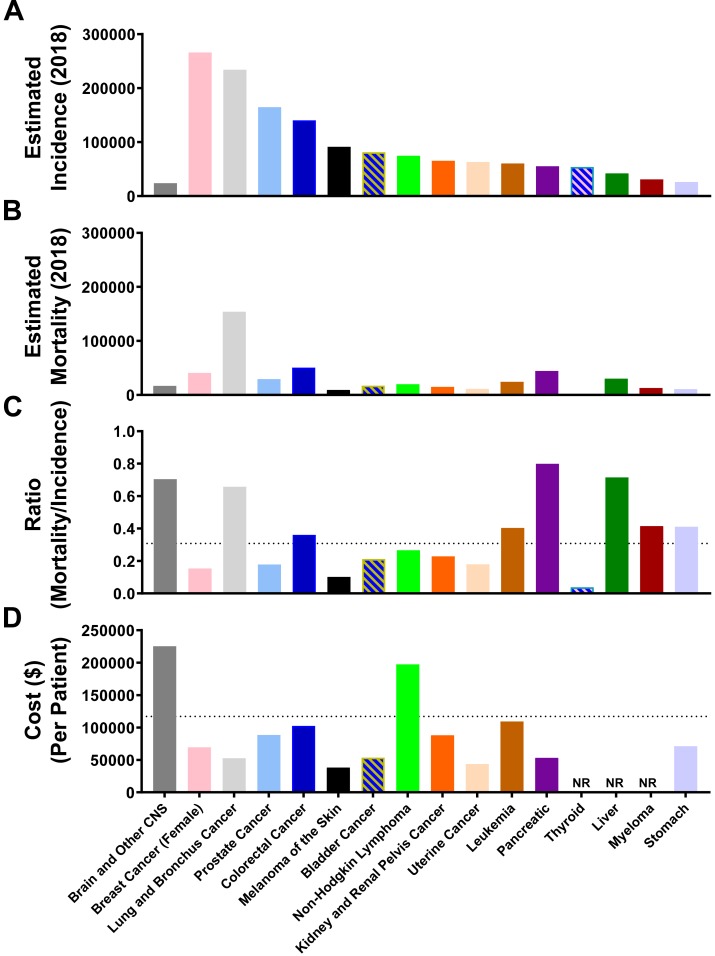
Brain and other CNS cancer is associated with a high mortality/incidence ratio and is expensive to treat. The estimated total (A) incidence and (B) mortality rate for the top 16 cancer types according to NCI Cancer Stat Facts. (C) The calculated mortality to incidence ratio (estimated mortality/estimated incidence) for the top 16 cancer sites according to NCI Cancer Stat Facts. The dotted line represents an average across all 16 cancer types. (D) Cost (United States dollars) per patient for each of the top 16 cancer types. Dotted line represents the average for all 16 cancer types. NR, Not reported.